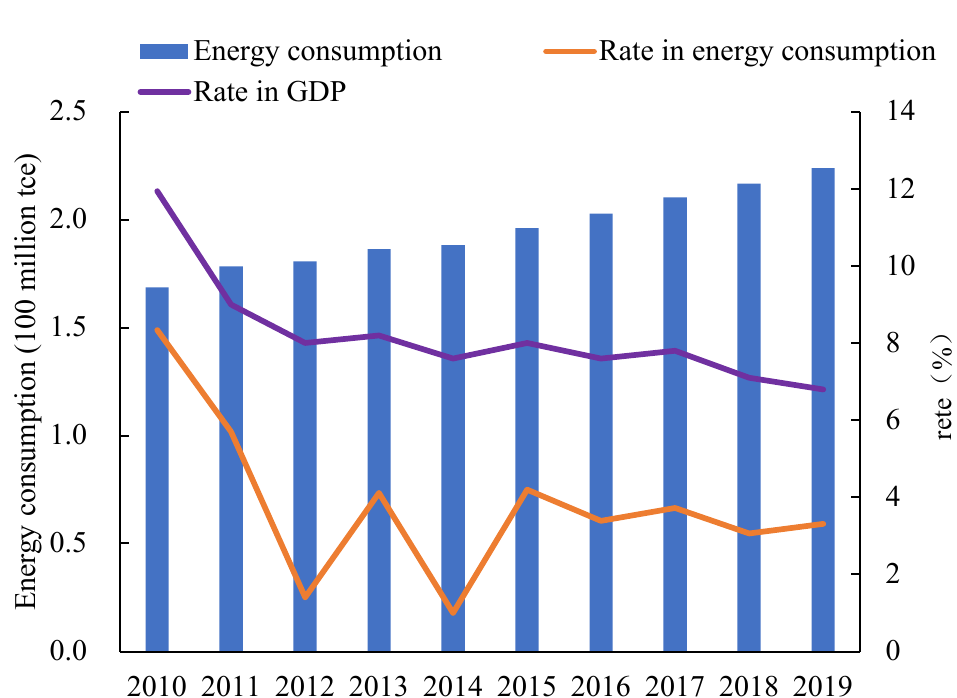
Figure 2. Energy consumption of Zhejiang province from 2010 to 2019. Note: Data are calculated on the basis of the 2011–2020 Zhejiang Statistical Yearbook and Zhejiang Statistical Bulletin.